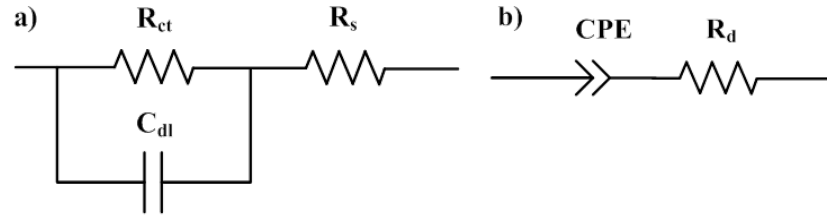
Figure 4. ( a ) Equivalent electric circuit for a frequency range from 10 to 10 7 Hz; ( b ) equivalent electric circuit for a frequency range from 10 −1 to 10